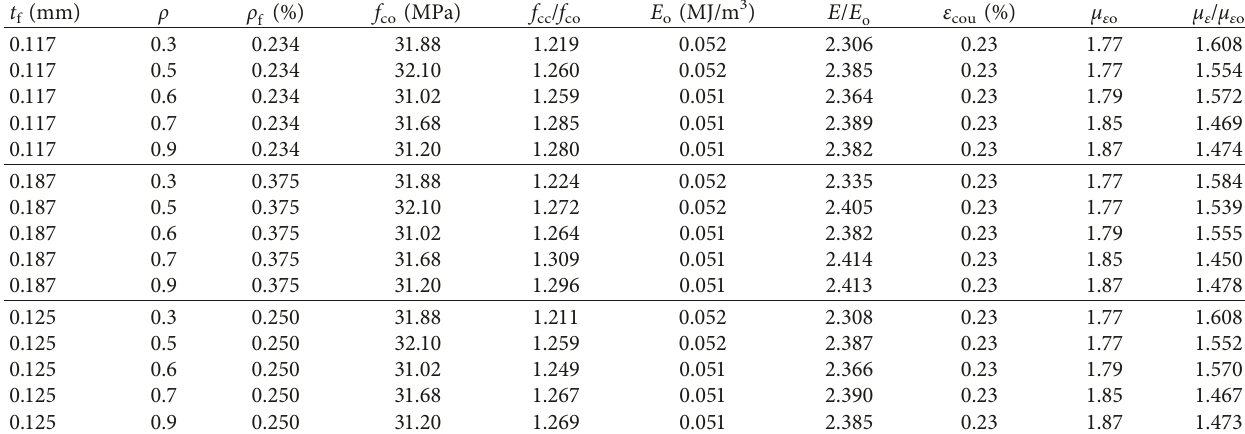
Table 3: Details of FE models for FRP-confined columns and numerical key